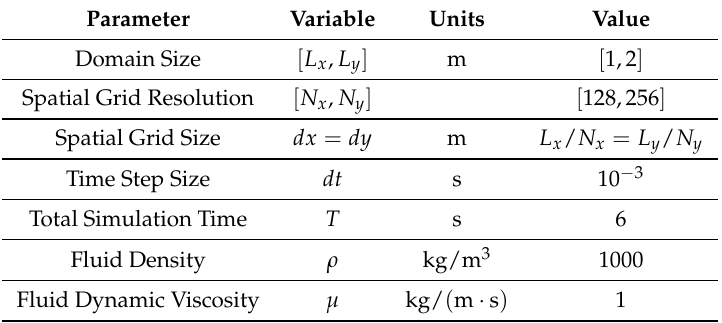
Table 3. Numerical parameters for the Cavity simulation for Re =